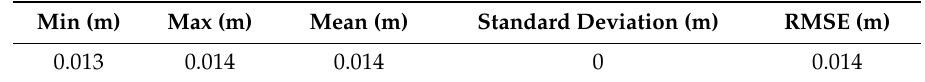
Table18. StatisticalvaluesoftheresidualsfortheNorthcoordinatesafterreprojectionfromUTM / WGS84 to OSPM / WGS84.